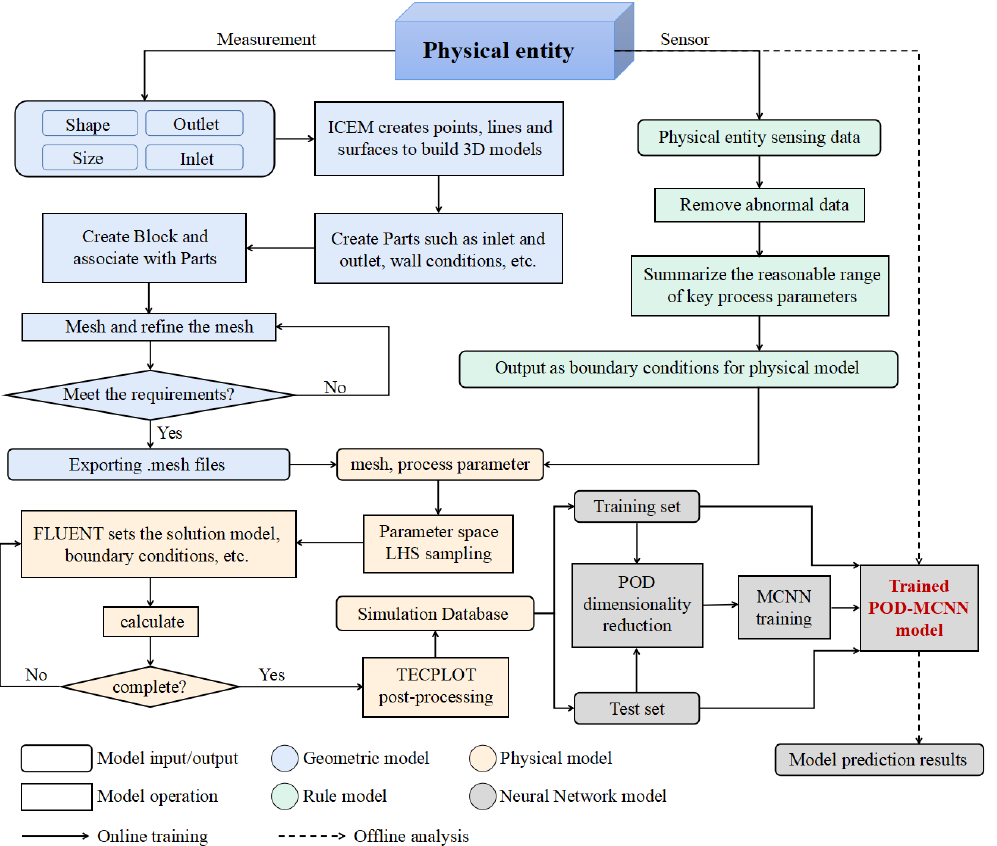
Figure 3. Proposed digital twin workflow.